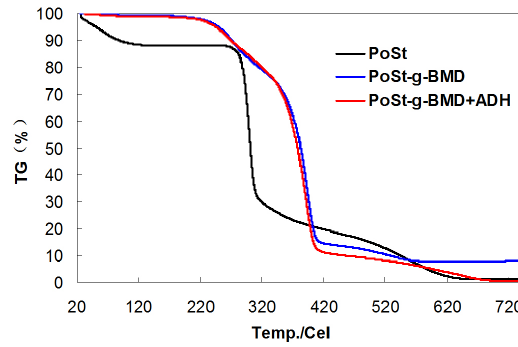
Figure 8. FT-IR spectra of PoSt, PoSt-g-BMD and PoSt-g- BMD + ADH copolymer.